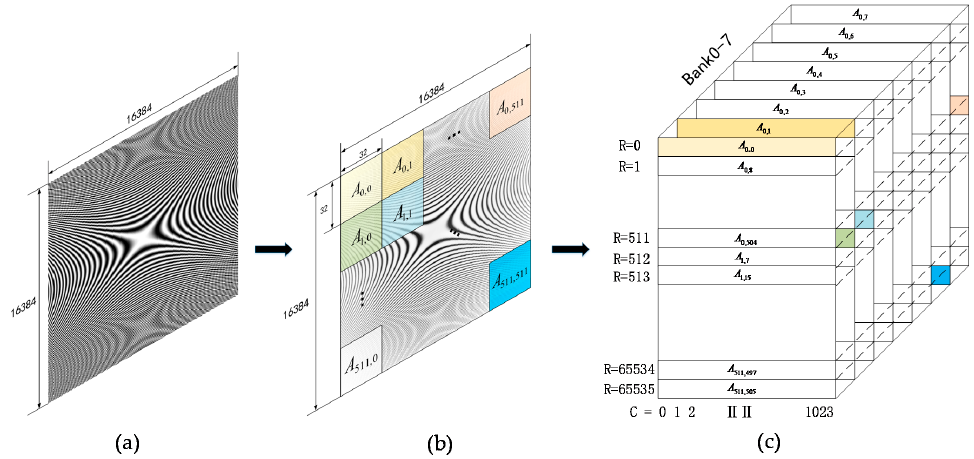
Figure 7. Schematic diagram of three-dimensional mapping for SAR data matrix (take a 16,384 × 16,384 matrix as an example). ( a ) The SAR raw data matrix; ( b ) the SAR raw data matrix is chunked into many sub-matrices; ( c ) each sub-matrix is mapped to a row in DDR3 by using the three-dimensional mapping method.